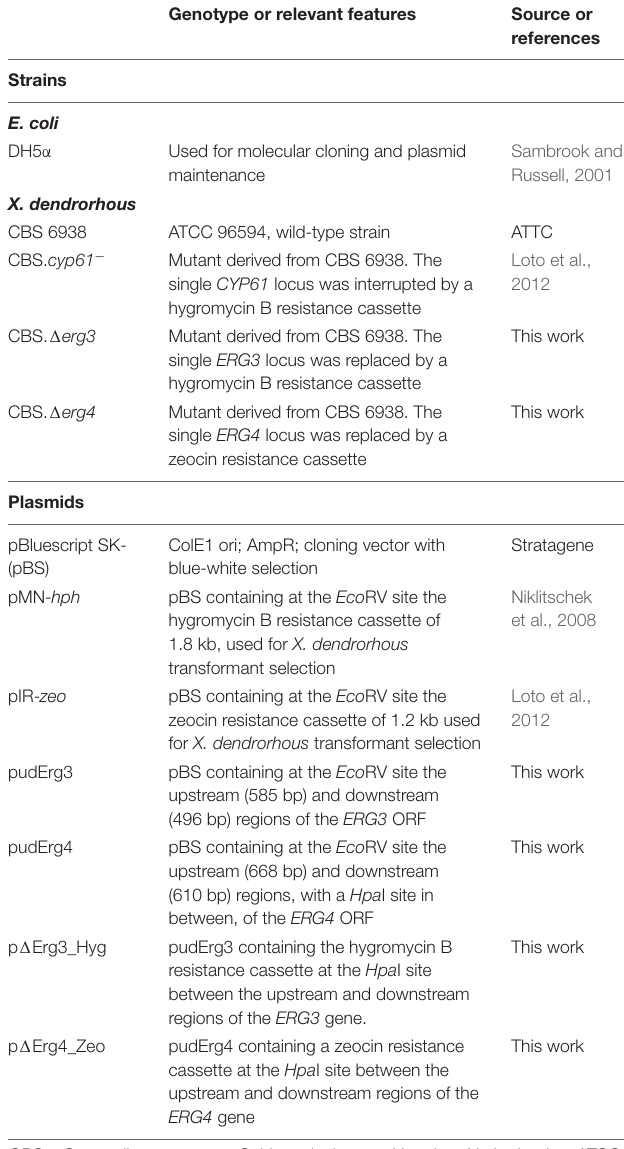
TABLE 1 | Strains and plasmids used and built in this